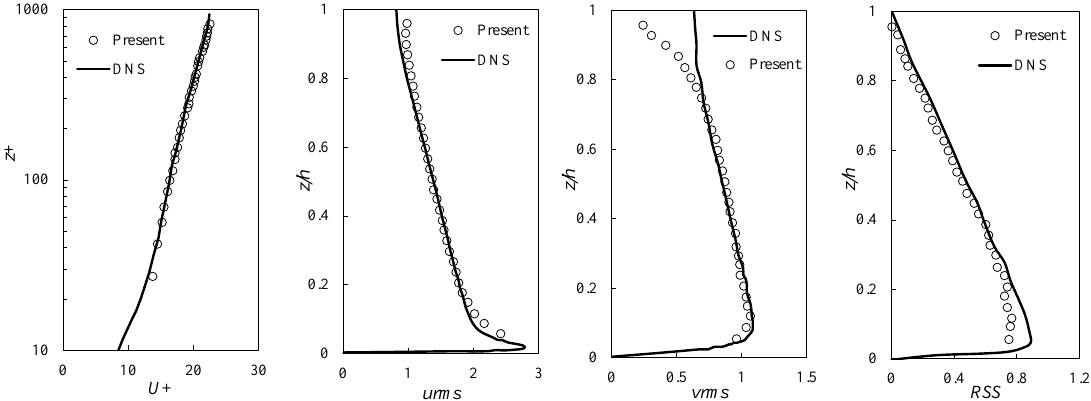
Figure A1. Comparison of velocity and turbulence quantities by the present particle image velocimetry (PIV) measurement with direct numerical simulation (DNS)